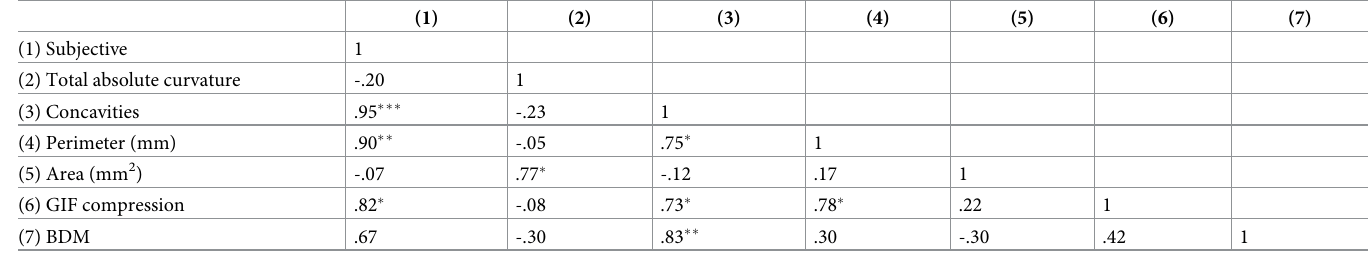
Table 1. Spearman’s rank order correlations between different measures of